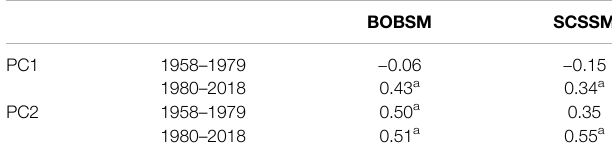
TABLE 2 | Correlation coef fi cients between the fi rst two EOF modes obtained from 150 hPa geopotential height in May (shown in Figure 6 ) and the onset of BOBSM and SCSSM during the period of 1958 – 1979 and 1980 – 2018,